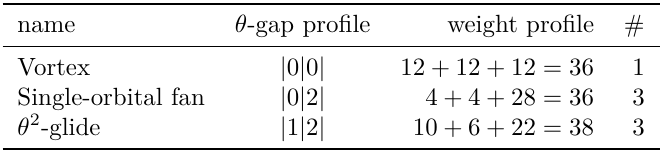
Table 9: Inherent